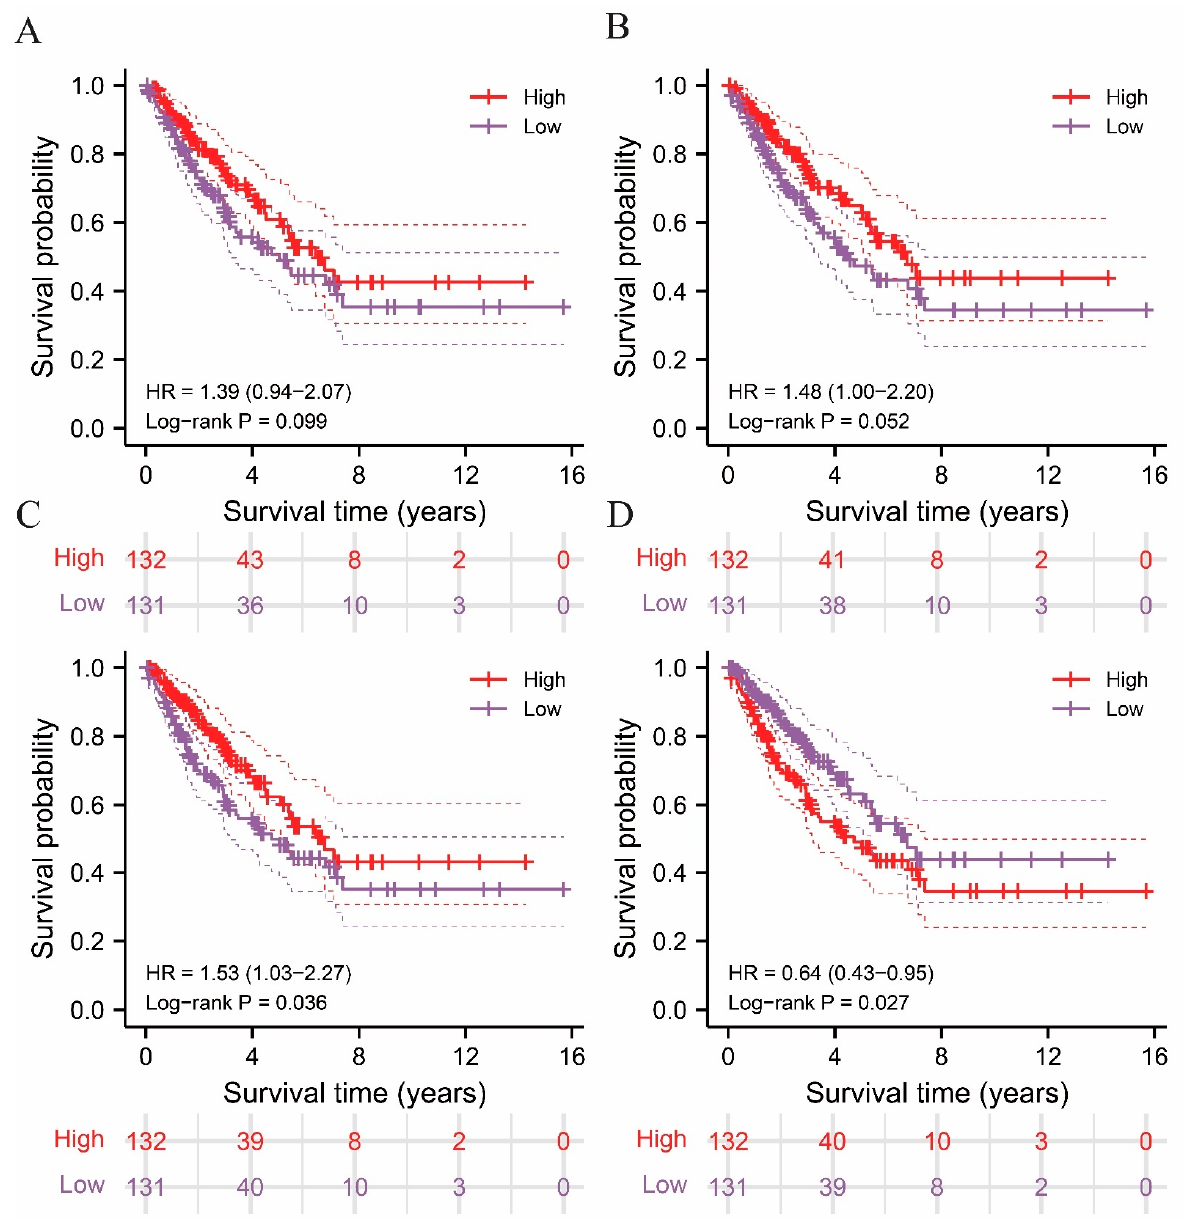
Figure 1. Survival analysis performed in high and low immune score groups using ESTIMATE algorithm and illustrated in Kaplan–Meier (K-M) curves. ( A ) Immune score, ( B ) stromal score, ( C ) ESTIMATE score, and ( D ) tumor purity score.